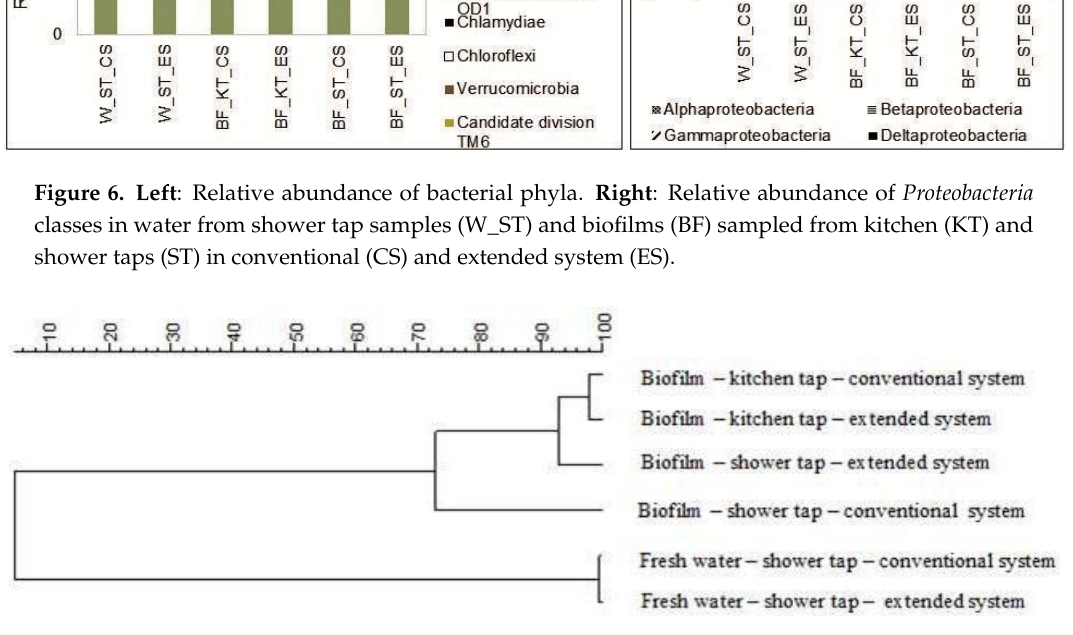
Figure 7. UPGMA Pearson correlation for the biofilm and water samples at genus level.